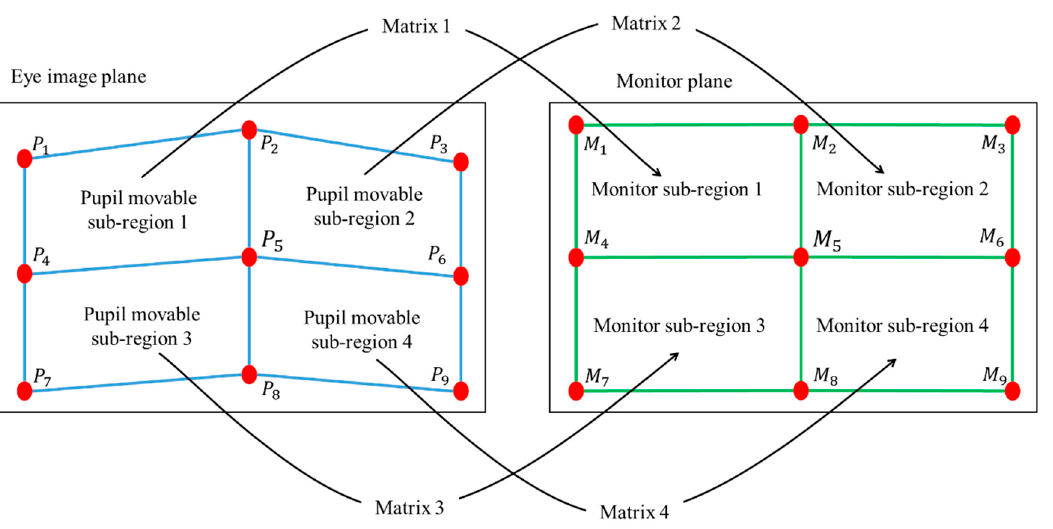
Figure 3. Relationship between pupil movable sub-regions and monitor sub-regions.